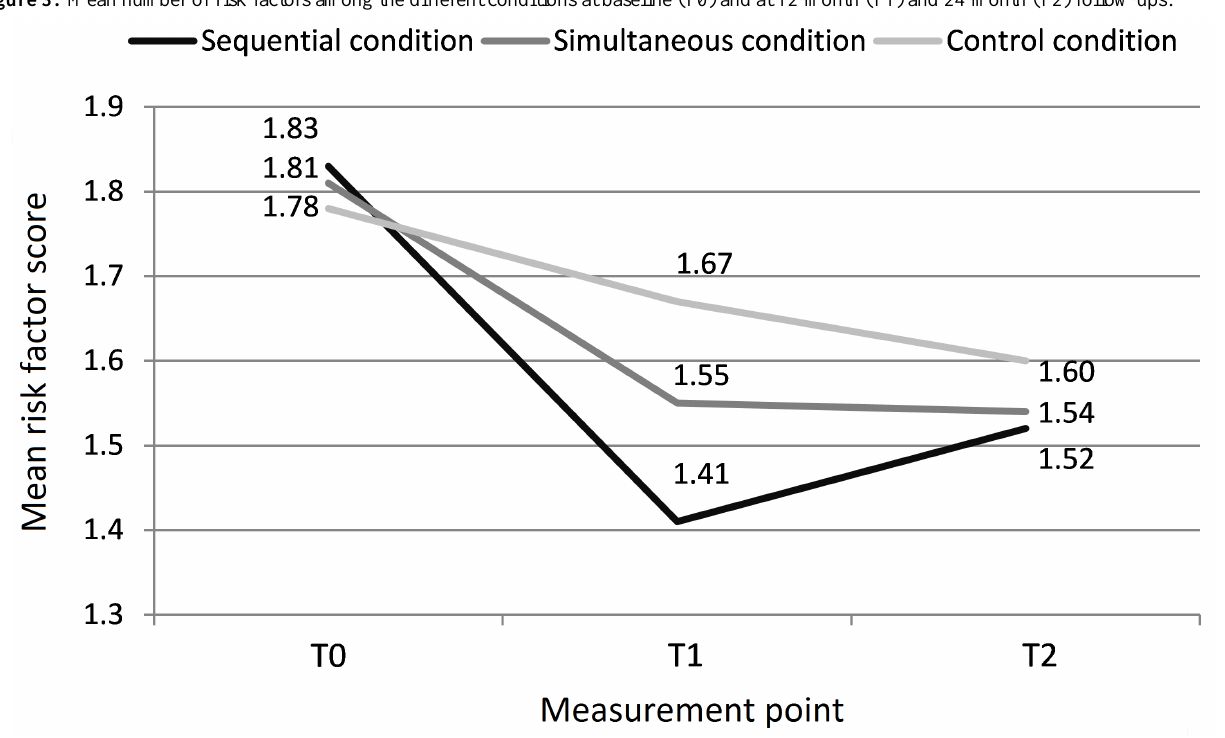
Figure 3. Mean number of risk factors among the different conditions at baseline (T0) and at 12-month (T1) and 24-month (T2)